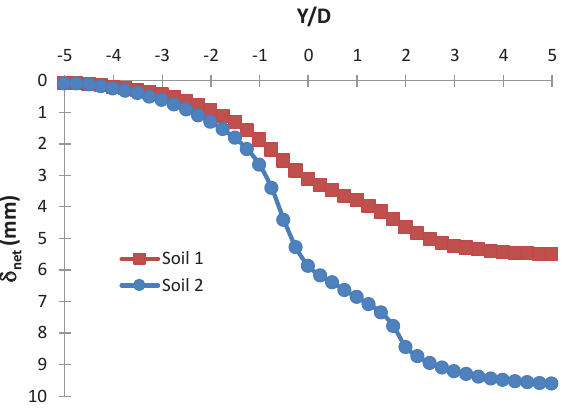
Table 5. Analysis series for a single and group of piles with different depth ratio (C/D)